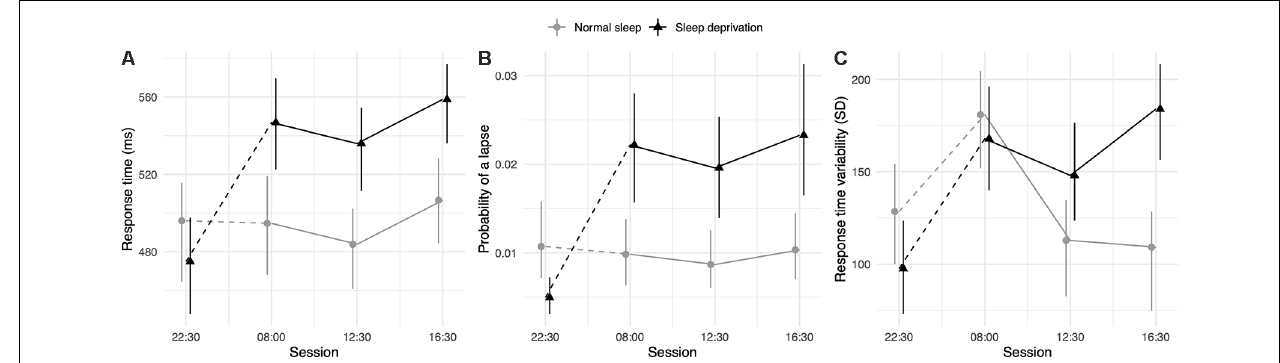
FIGURE 1 | Simple attention test performance depending on sleep condition and time of day. (A) Represents performance measured as response time (RT; in ms). (B) Represents performance measured by the probability of a lapse (lapse = response >1,000 ms). (C) Represents performance measured as RTV (standard deviation of response time in ms). Dots represent fixed-effect estimates and error bars represent bootstrapped confidence intervals with 100 iterations. The dotted line between 22:30 h and 08:00 h represents the night of total sleep deprivation for the sleep-deprivation group.